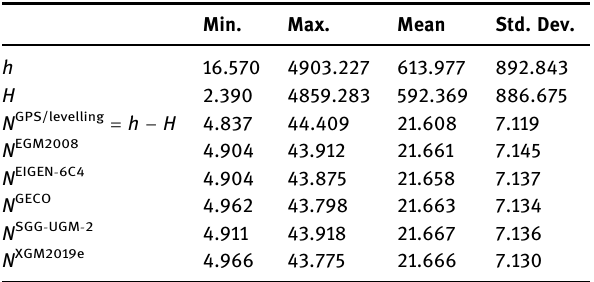
Table 2: Statistics of ellipsoidal, orthometric, and geoid heights on benchmarks in meters